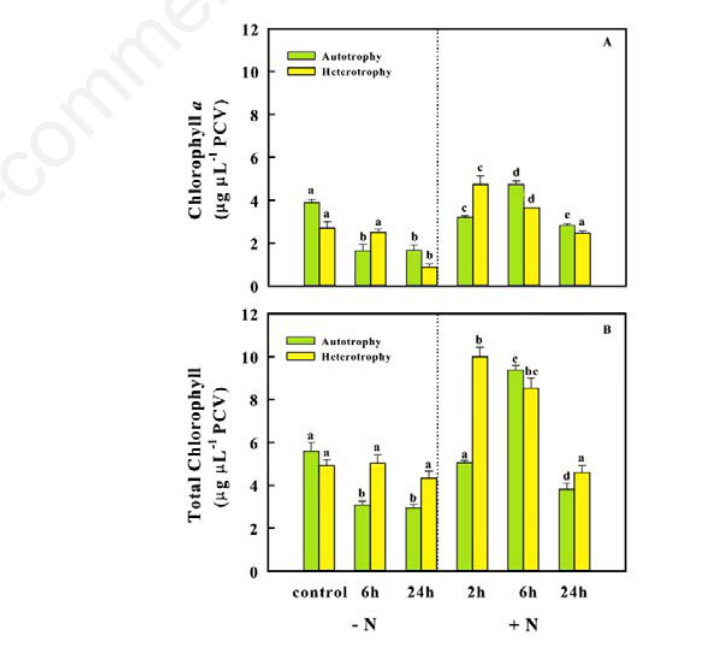
+ availability (N) in 4